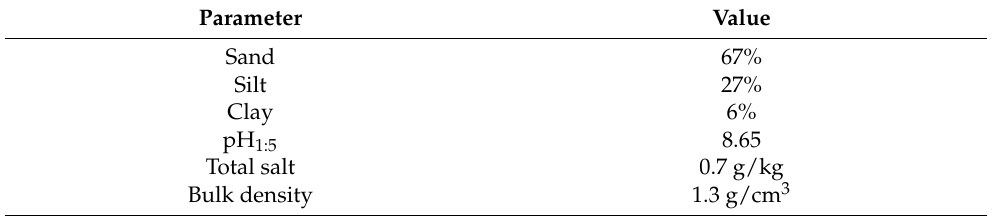
Table 1. Characteristics of the